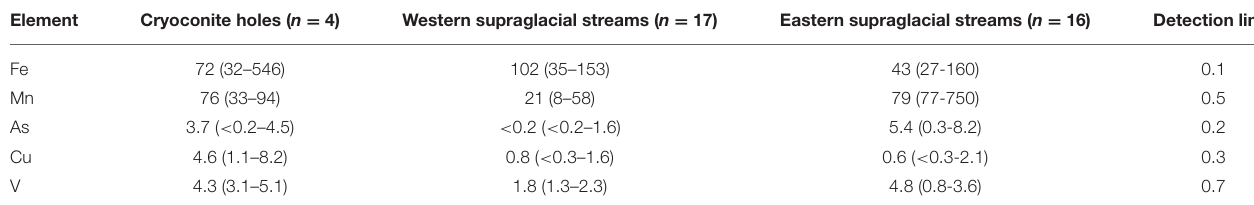
TABLE 1 | Median and range () of dissolved element concentrations (nM) in supraglacial waters of Canada Glacier, Taylor Valley, Antarctica. Element